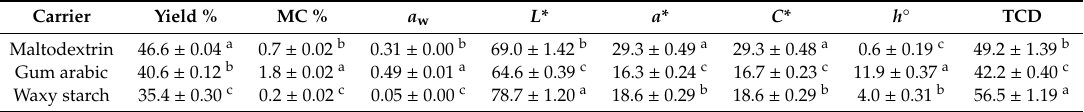
Table 2. Yield, moisture content, water activity and colour attributes of freeze-dried pomegranate juice powder